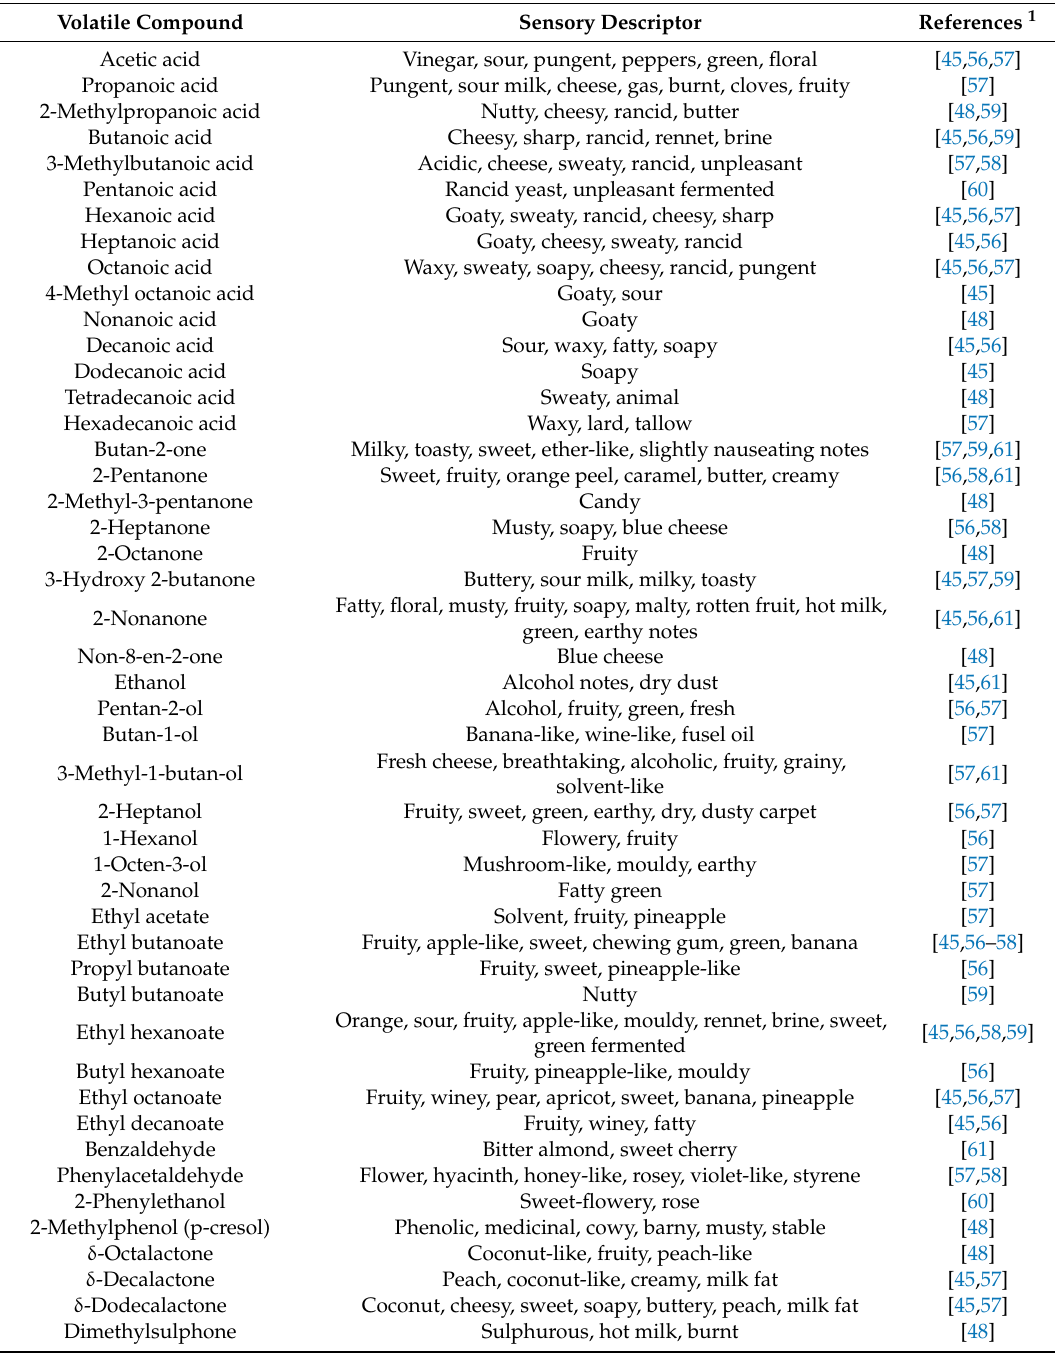
Table 5. Volatile compounds associated with sensory